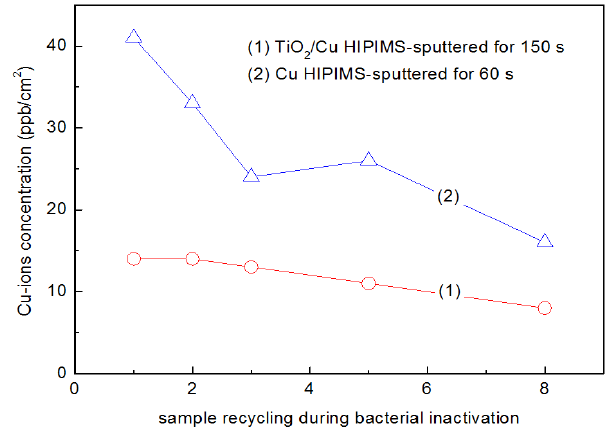
Figure 8. The concentration of ions eluted into solution determined by Inductively Coupled